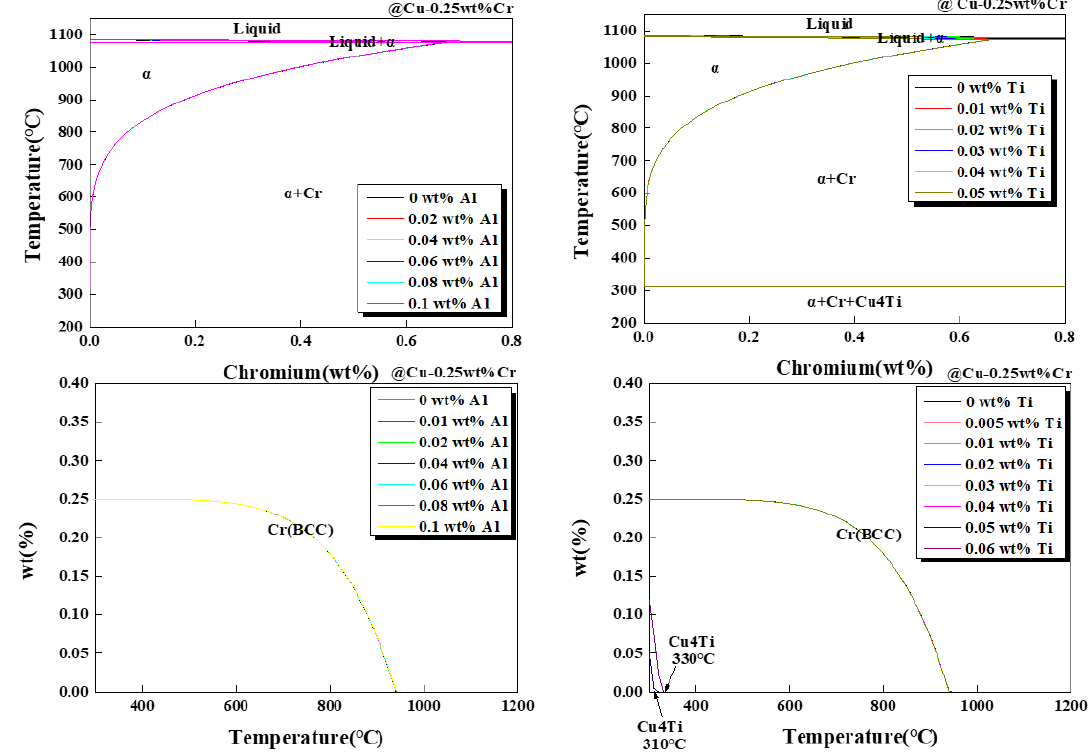
Figure 11. Prediction of solubility and crystallization phase of Cu-Cr alloys by FactSage ®.